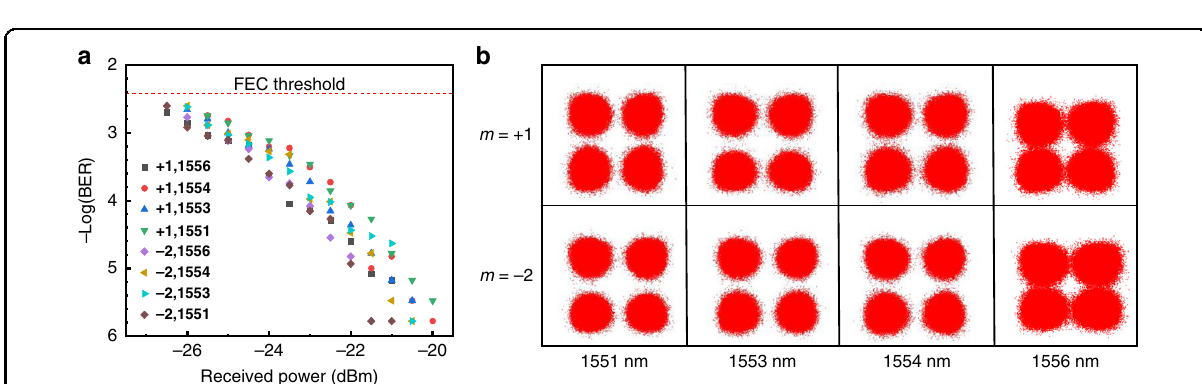
Fig. 5 Experimental results are used to prove that the metasurface-based CVB mode multiplexer/demultiplexer is compatible with polarization multiplexing. a Measured mode crosstalk of four CVB mode channels. b BERs corresponding to eight CVB mode channels at 1554 nm. c Constellations of the QPSK signals of CVB modes ( m = ±1, ±2) with x -pol and y -pol, respectively